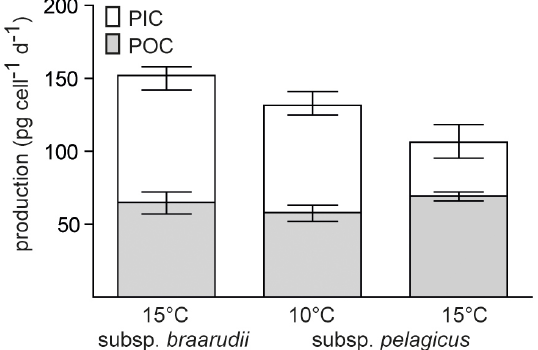
Figure 3. Particulate organic (POC) and particulate inorganic car- bon (PIC) production of Coccolithus pelagicus subsp. braarudii grown at 15 ◦ C and subsp. pelagicus grown at 10 and 15 ◦ C in high- P medium. Mean ± min/max. Values are from main experiments only, n =